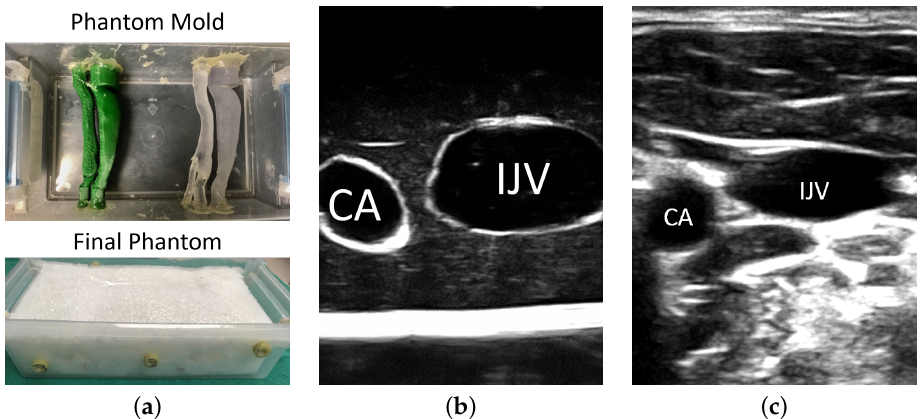
Figure 2. Anthropomorphic Phantom for simulated CVC procedures: ( a ) positive mold of the neck vasculature was embedded into an US-compatible tissue-mimicking material (PVAc) to create a wall- less hollow structure, ( b ) SAX view of the phantom depicting the simulated CA and IJV, and ( c ) SAX view of human neck vessels as an example of vascular anatomy under ultrasound courtesy of a healthy volunteer.